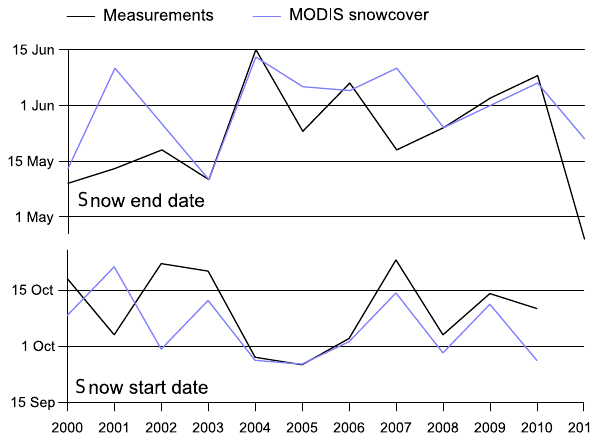
Figure 4. Modeled and measured snow start and end date on Samoylov Island (Boike et al.,